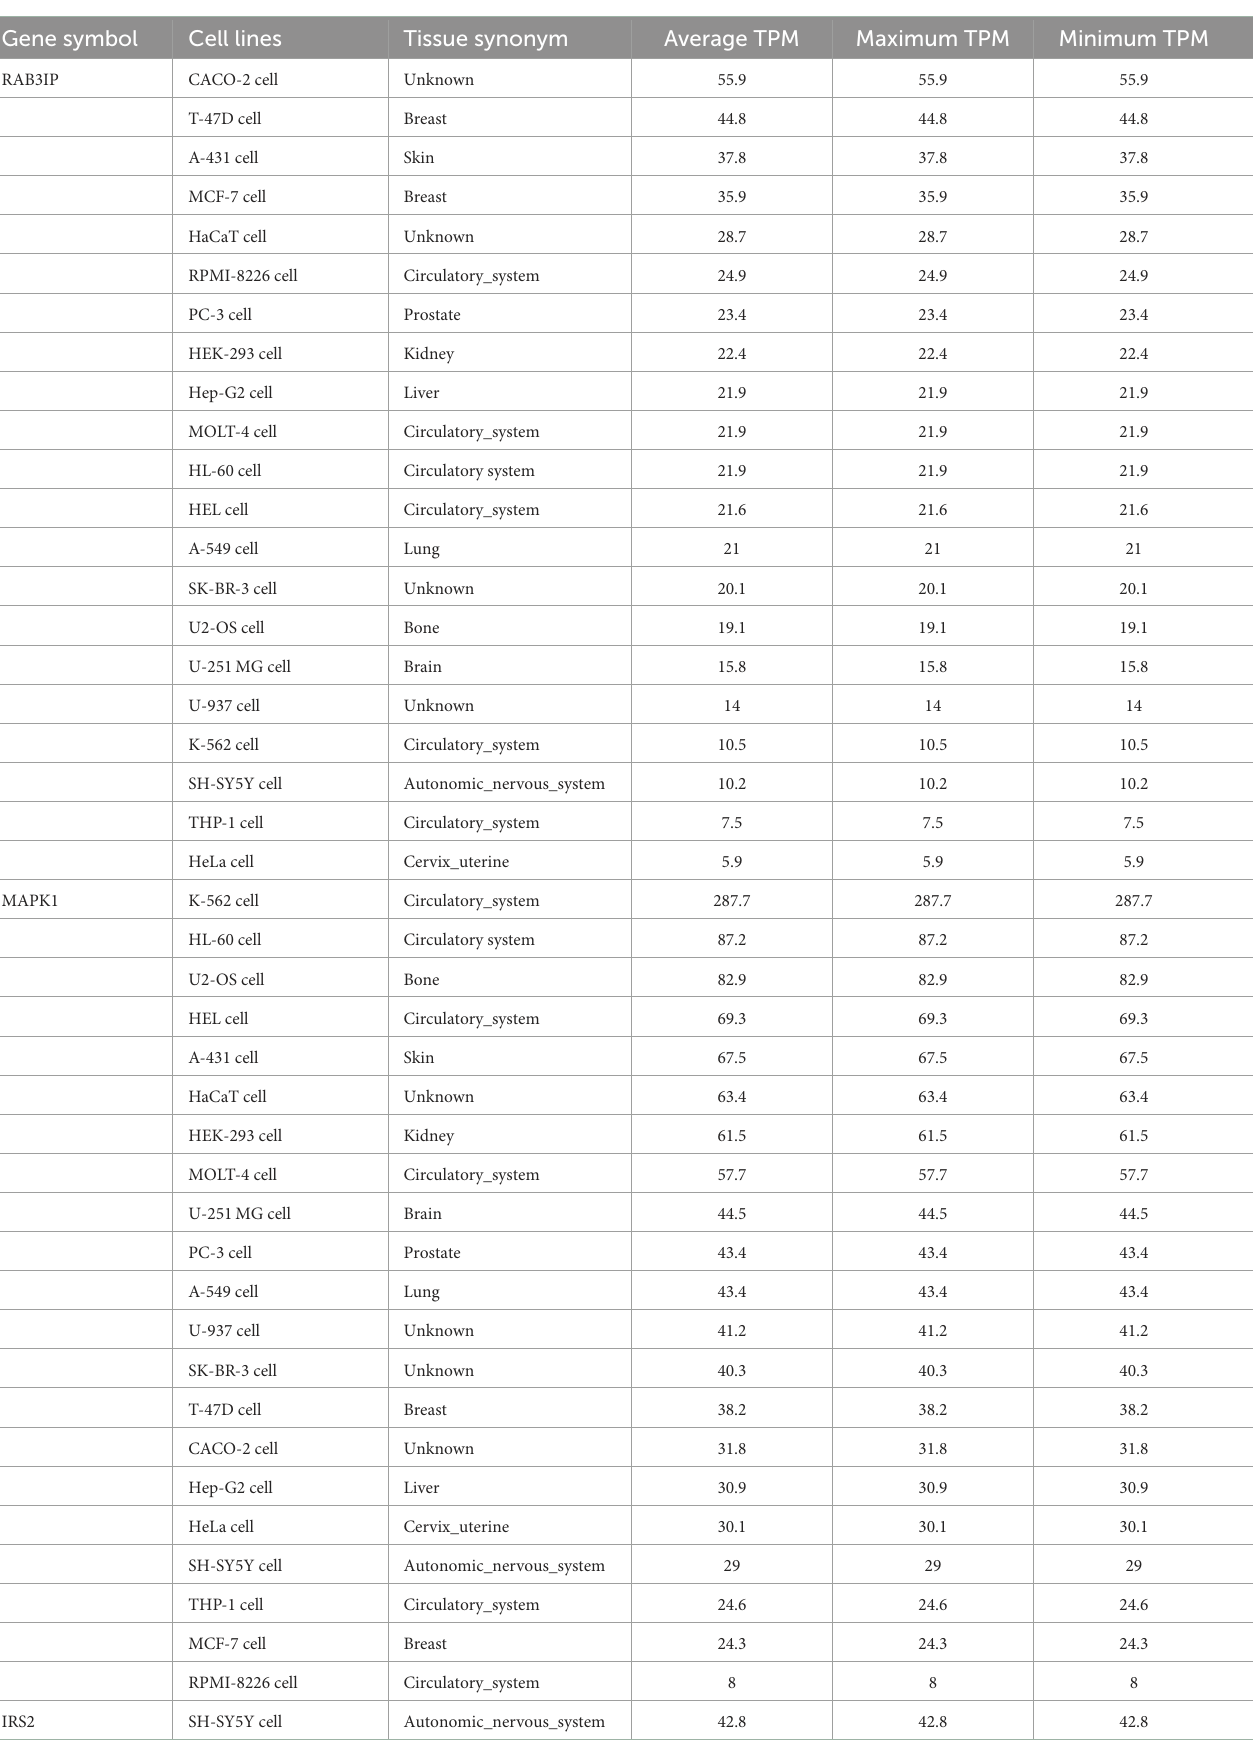
TABLE 2 The expression levels of RAB3IP, IRS2, and MAPK1 in different cell lines. Gene symbol Cell lines